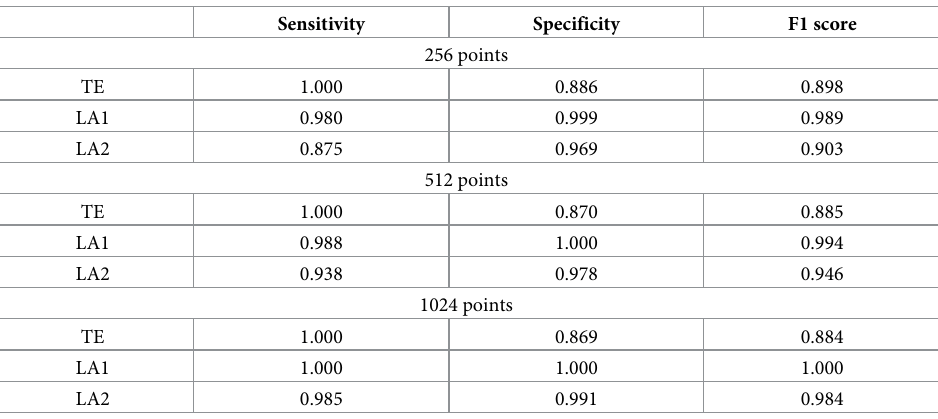
Table 1. Sensitivity, specificity and F1 score values obtained from Model